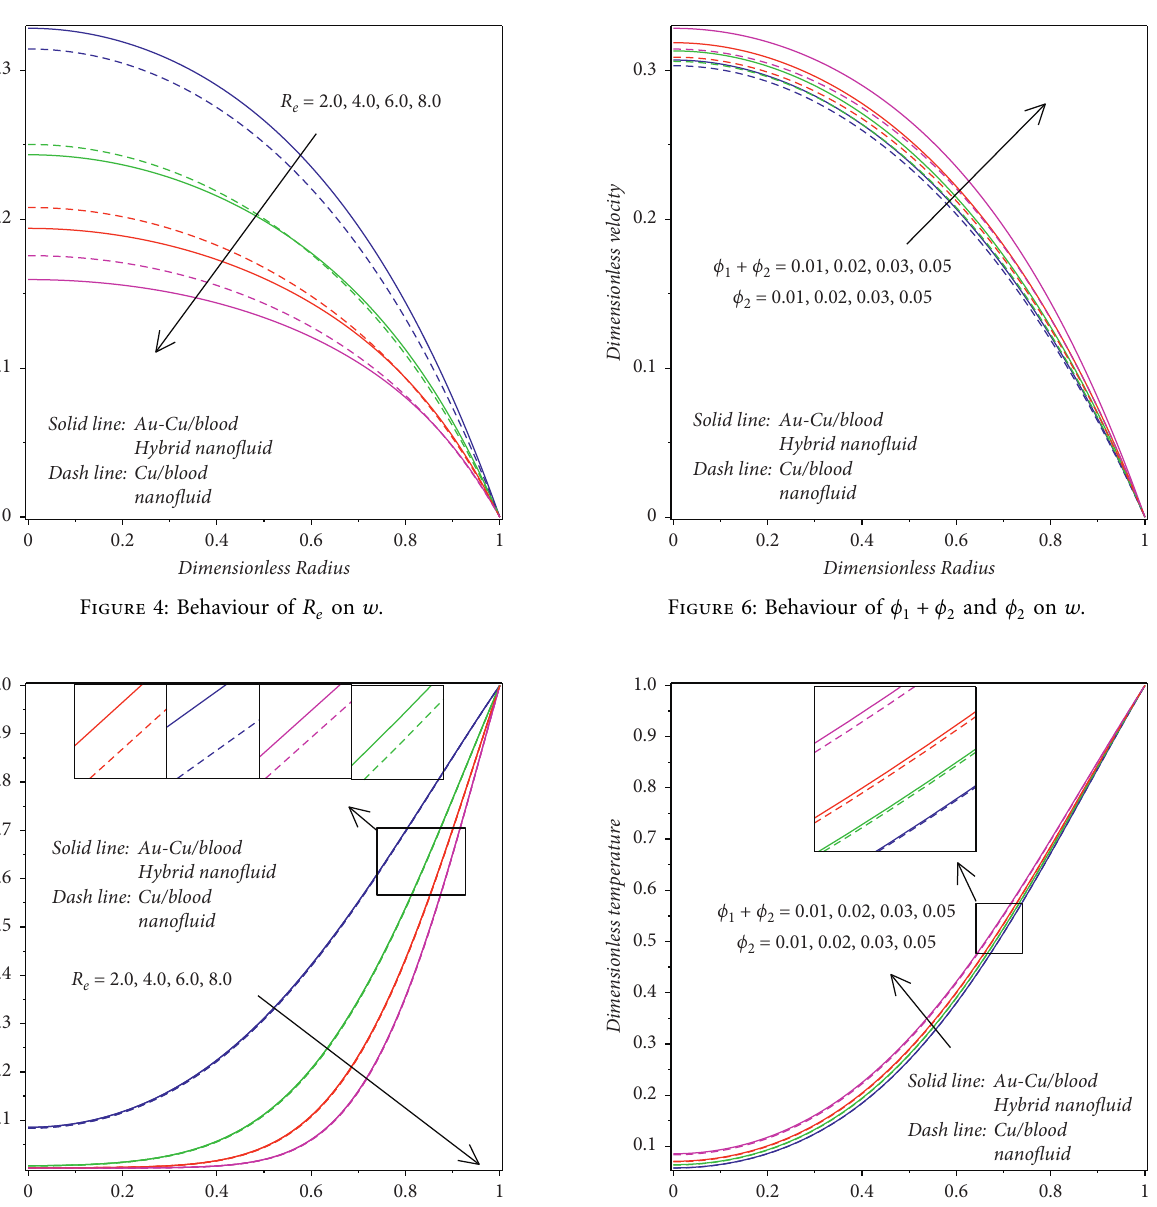
Figure 5: Behaviour of R